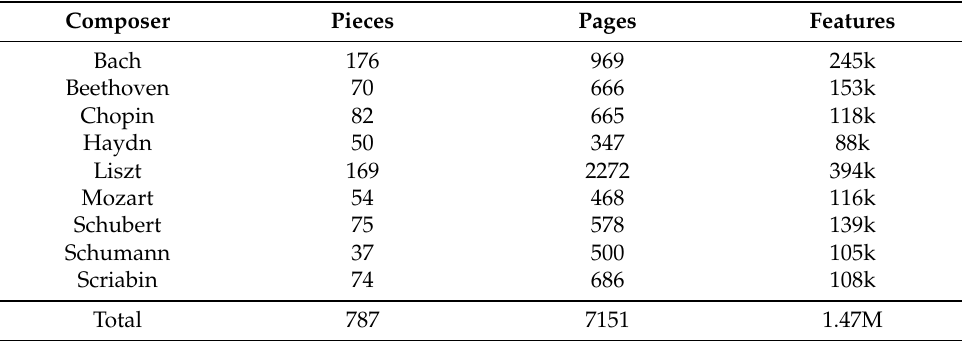
Table 1. Overview of the labeled (full-page) dataset used for classifier finetuning. Composer Pieces Pages